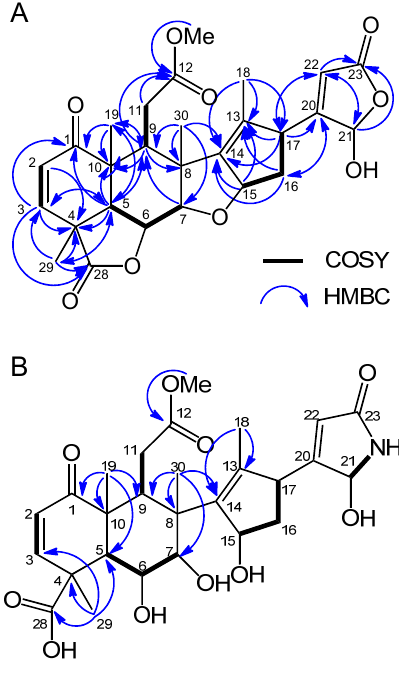
Figure 3. COSY and HMBC correlations of compound 1 ( A ) and 2 ( B